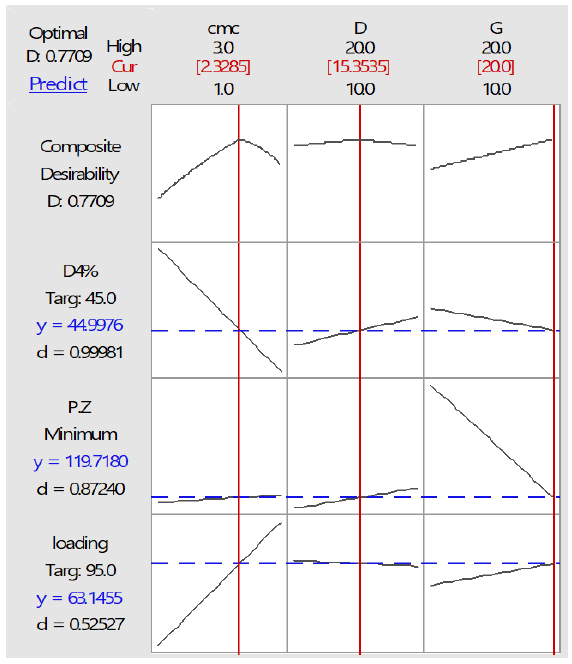
Figure 3. Desirability plot of optimize polymeric micelle formulation (representative optimal amounts of surfactant, ciprofloxacin and G-Rg3 for providing desired values of D4%, particle size (P.Z) and drug loading (EE%).